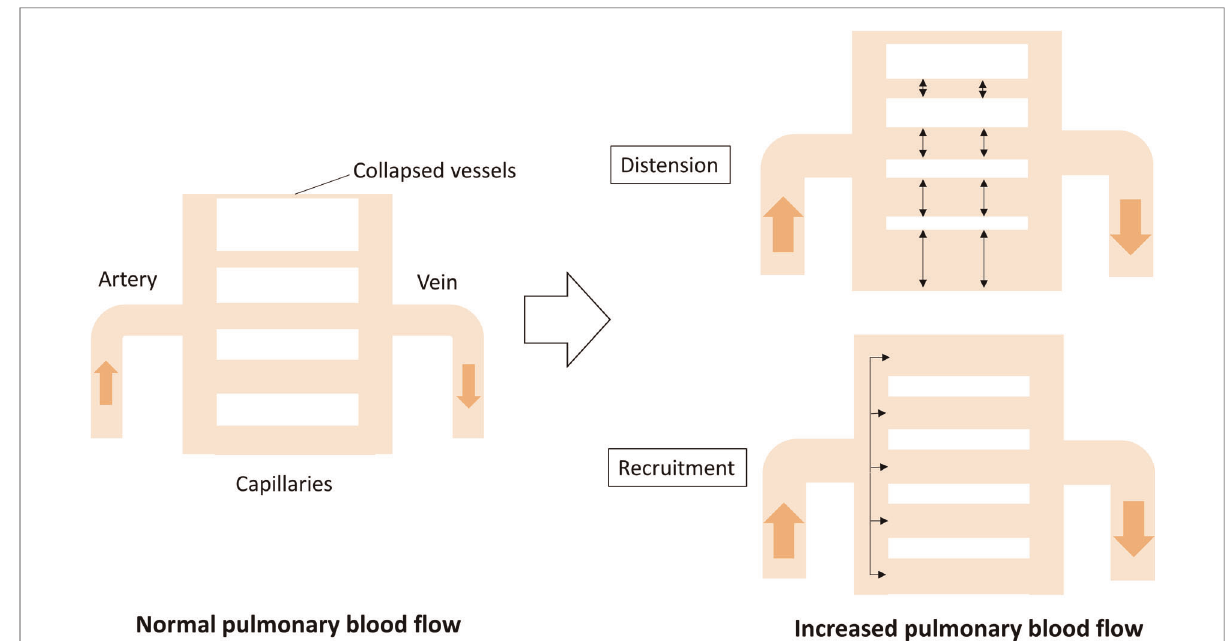
FIGURE 2 Cp determined by distention and recruitment of pulmonary vessels including capillaries. When cardiac output increases, the blood fl ow is accommodated by distention and recruitment, ensuring that the pulmonary circulation is highly compliant. Cp, pulmonary vascular